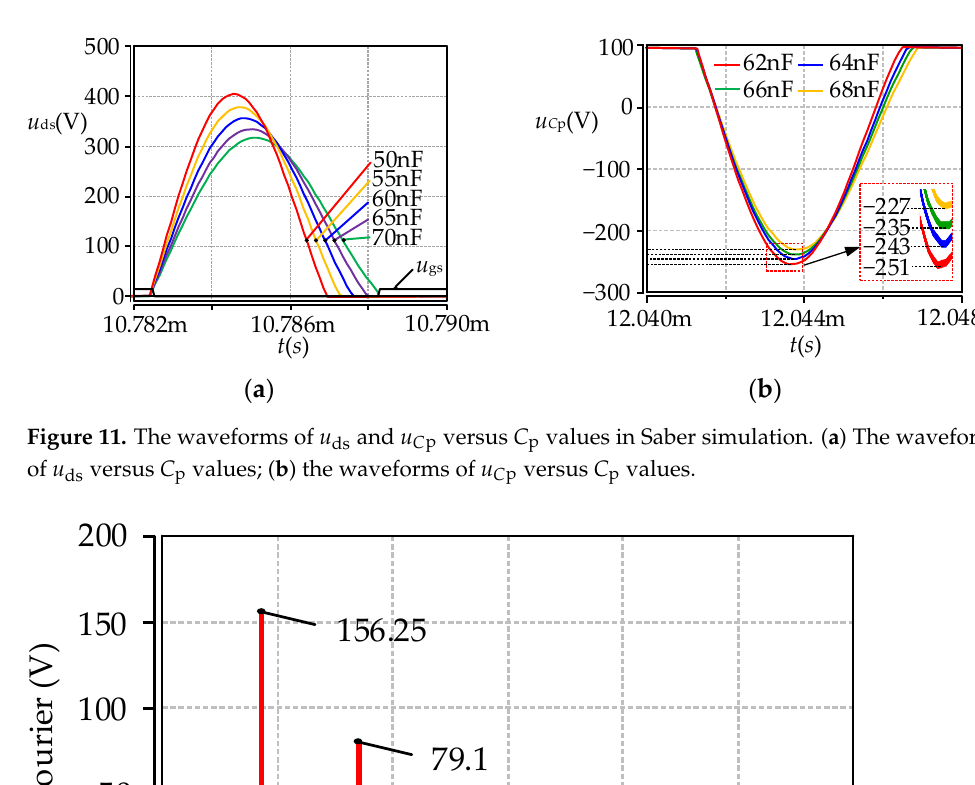
Figure 12. Fourier decomposition diagram of the voltage u C p in Saber simulation.